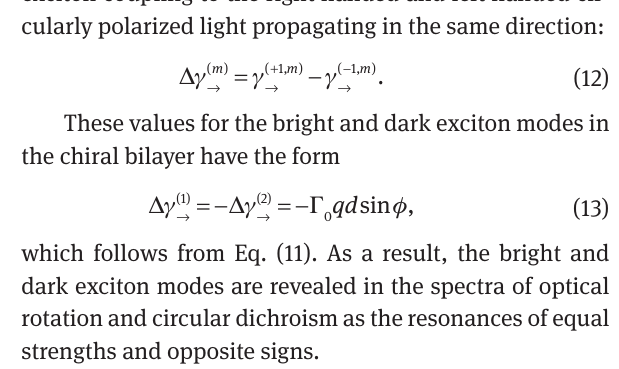
light propagating along the z axis ( → ) or in the opposite